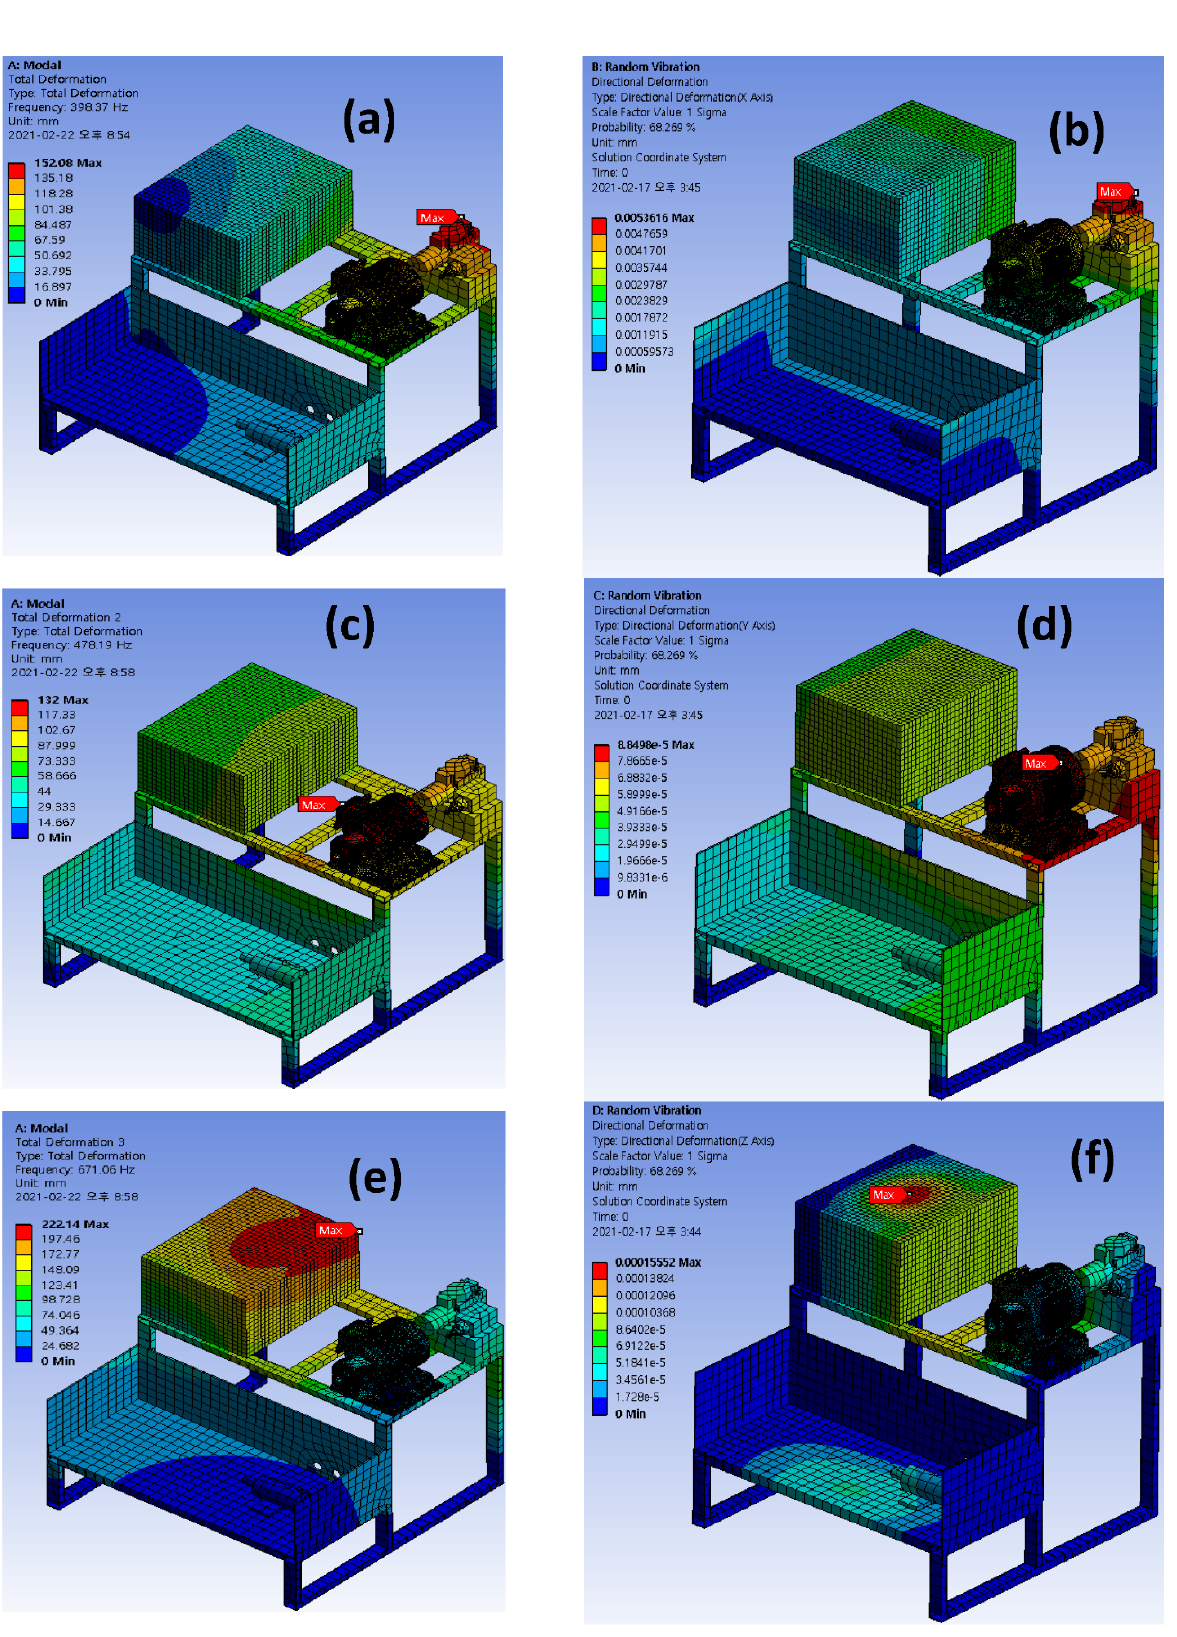
Figure 5. Mode extraction using FEM analysis. ( a ) 1st mode, ( b ) 2nd mode, ( c ) 3rd mode, ( d ) X -Axis, ( e ) Y -Axis, ( f ) Z -Axis.